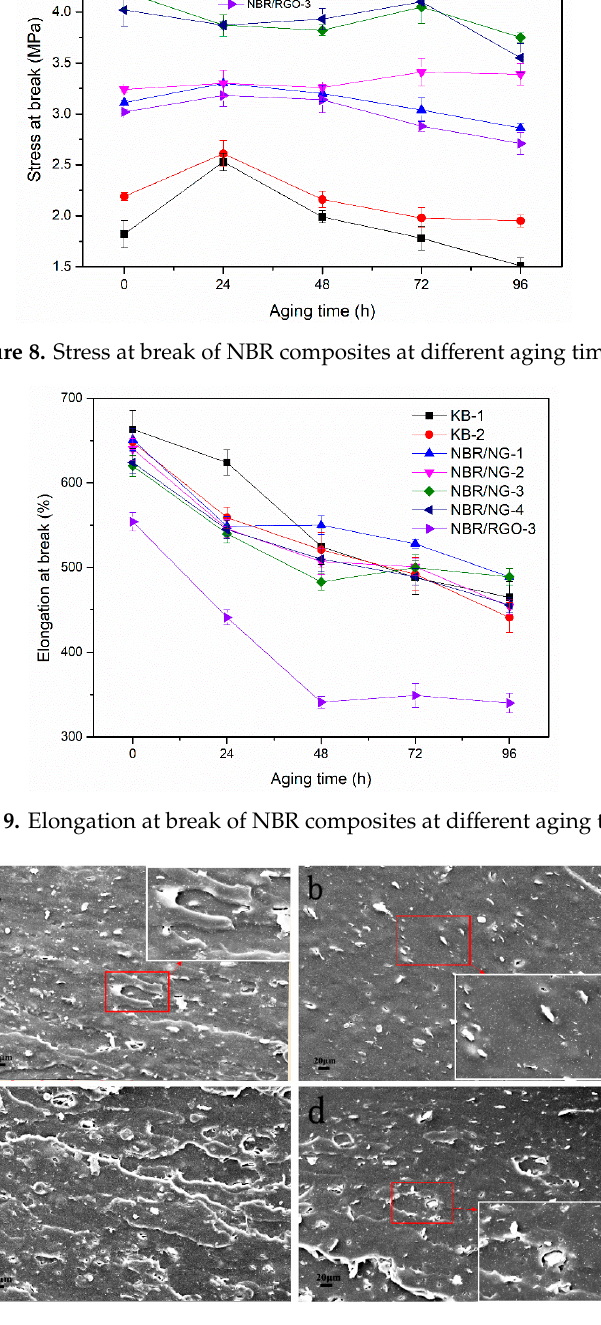
Figure 10. SEM images of the fracture surface of NBR/NG-3 ( a ) before aging and ( c ) after aging; fracture surface SEM images of NBR/RGO-3 ( b ) before aging and ( d ) after